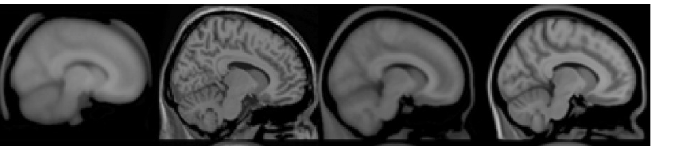
Figure 8. The sagittal plane of standard MRI templates: average305, colin27, ICBM152 T1, NLICBM152 T1 (from left to right).